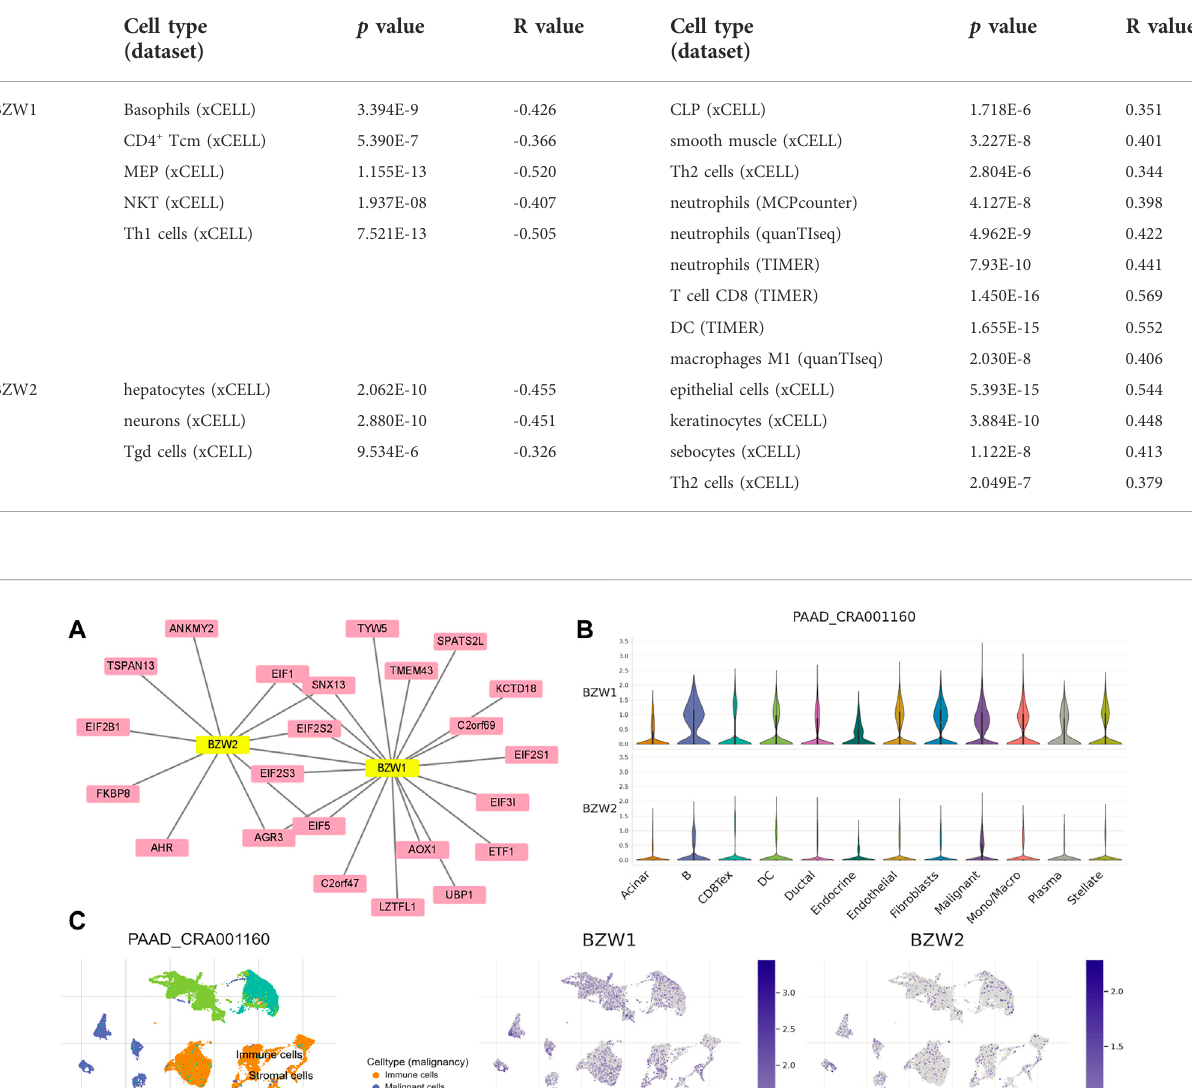
identi fi ed as BZW2 high-expression, and 31 were low-expression.